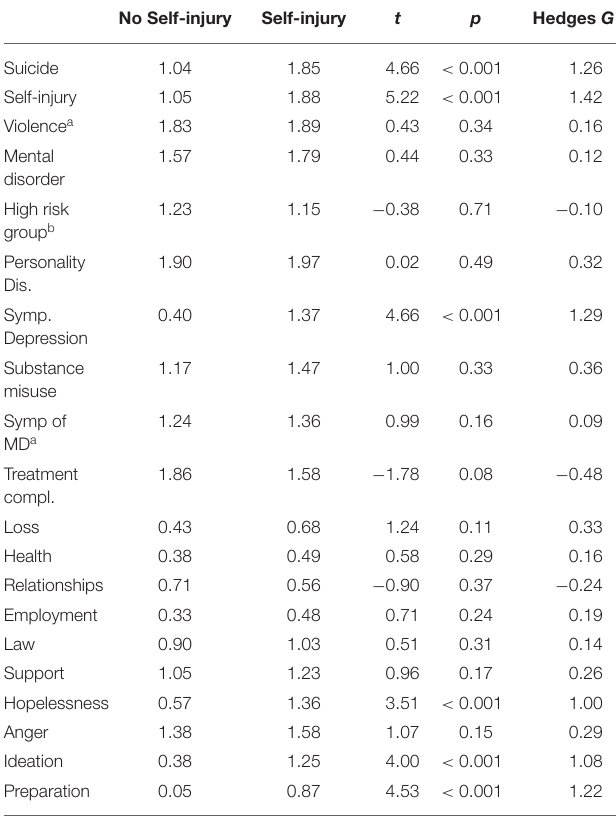
TABLE 5 | Mean RoSP scores and inferential statistics for the patients grouped as to whether they have an instance of deliberate self-injury during the study period. No Self-injury Self-injury t p Hedges